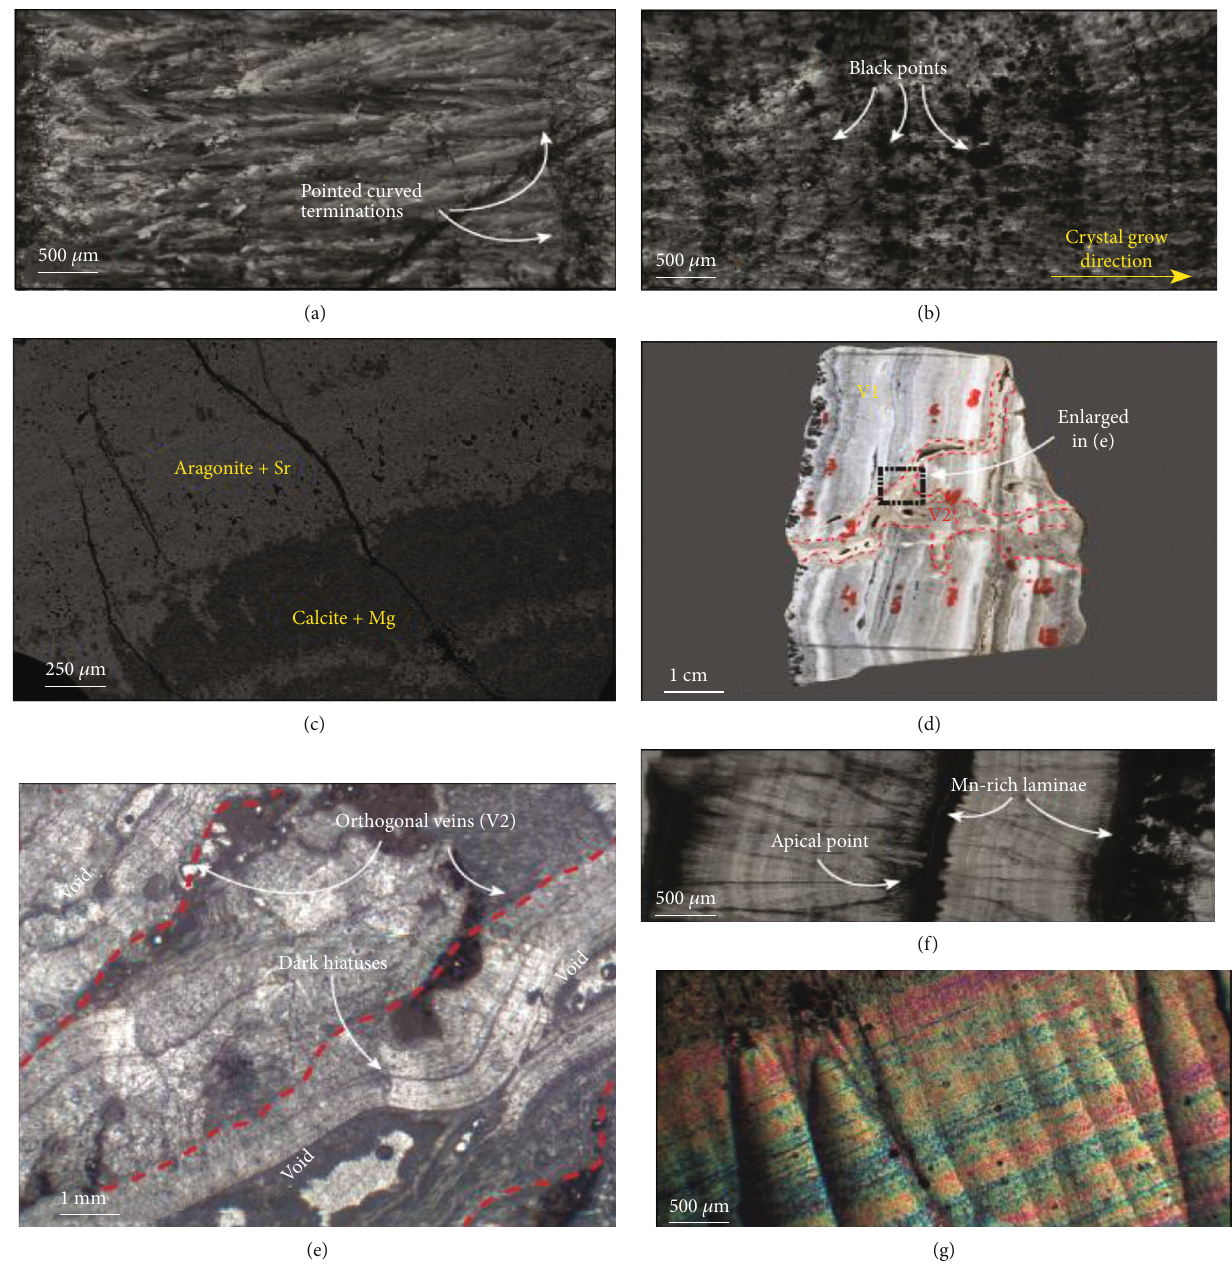
Figure 10: (a) Micrograph (crossed polars) of calcite crystals enlarging in the growth direction, showing their terminations characterized by pointed curved faces. (b) Micrograph (crossed polars) of calcite crystals perpendicularly crossed by aligned traces of Mn-oxides. (c) SEM image showing slightly darker calcite bands than aragonite ones, due to the presence of Mg in calcite crystals. (d) ET3 hand specimen showing vein V1 crossed by vein V2. (e) Micrograph (crossed polars) of part of the ET3 sample showing details of vein V2 characterized by millimeter-sized voids in the central part and small bands made up of elongate-blocky crystals growing toward the central part of the vein. (f) Micrograph (crossed polars) of vein V3 from the PAM1 sample showing acicular densely packed aragonite crystals, forming thin fans of ray crystals that develop from an apical point. (g) Micrograph (crossed polars) of the PAM13 sample showing needle-like aragonite crystals with very high interference